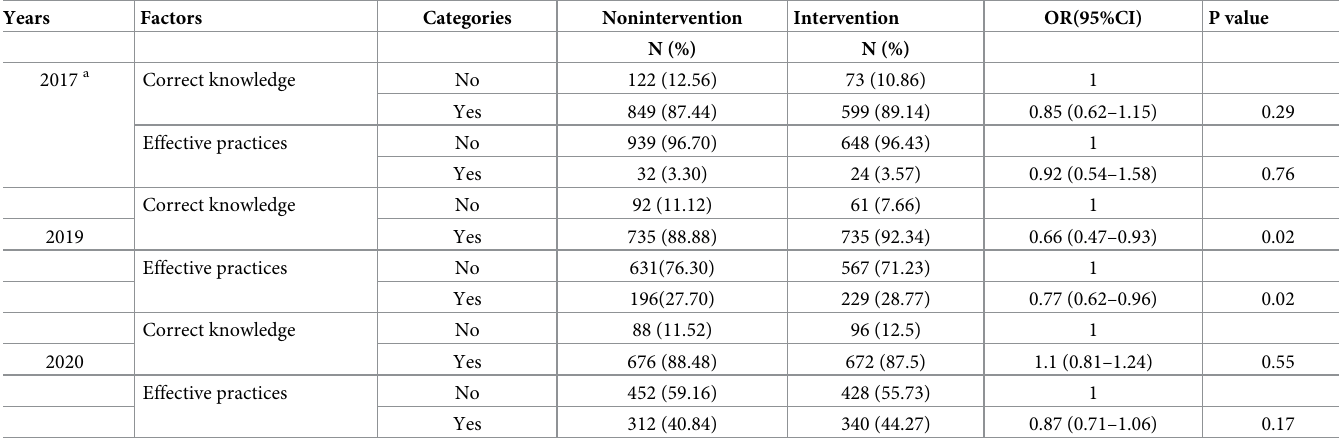
Table 4. Correct knowledge and practices about malaria during the implementation of the larviciding trial in Yaounde´. Years